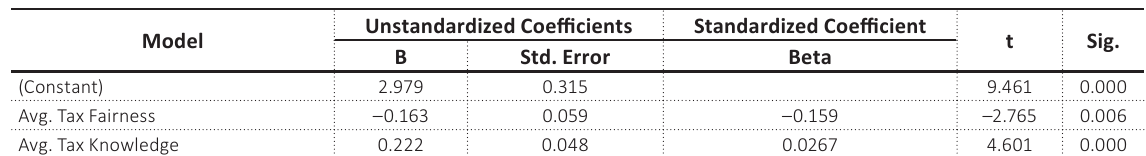
Table 3. Coefficients of independent